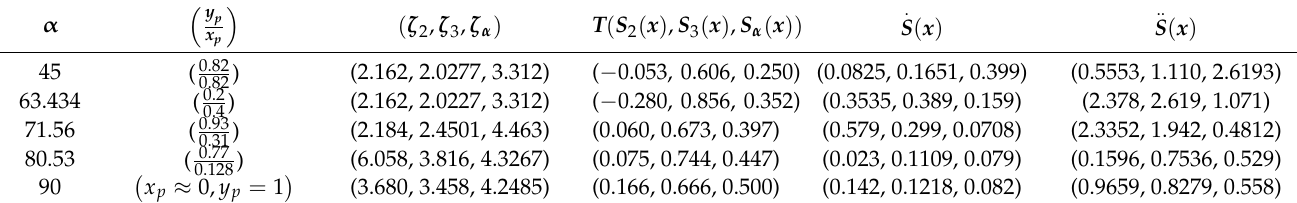
(cid:0) (cid:1) x p , y p is located in the second right , 𝑦 ) is lo- (cid:3043) (cid:3043) = 𝑞 = 𝑞 = 0 in the first (cid:2869) (cid:2870) (cid:2871)